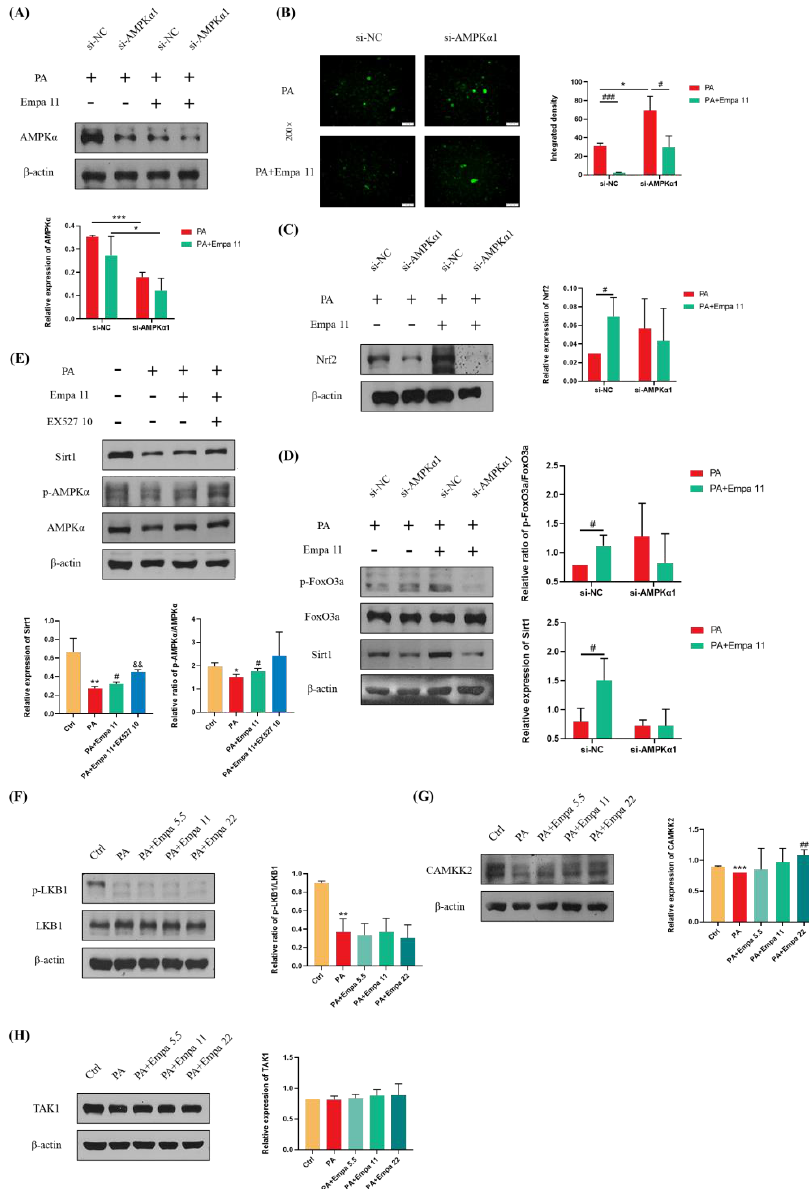
Figure 6. Effects of AMPK α 1 on the protective effects of Empa in a PA-induced lipotoxicity in LO2 cell lines and CAMKK2-mediated activation of AMPK α but not phosphorylation of LKB1 or TAK1. ( A ) AMPK α 1 knockdown treatment significantly reduced the level of AMPK α in LO2 cells. ( B ) AMPK α 1 knockdown treatment enhanced the intracellular ROS generation induced by PA in LO2 cells while inhibiting the ameliorative effect of Empa on the ROS produced by PA. ( C , D ) Empa enhanced the expression of Nrf2, Sirt1, and p -FoxO3a in PA-treated LO2 cells, but AMPK α 1 knockdown treatment partially inhibited this enhancement. ( E , F ) Empa did not regulate AMPK α activation through Sirt1 or the phosphorylation of LKB1 in the PA-induced lipotoxicity model. ( G ) CAMKK2 protein level was remarkably upregulated by Empa treatment. ( H ) Neither PA treatment nor PA + Empa treatment had a significant effect on the expression of TAK1. All data are expressed as mean ± SD ( n = 3). ( A – D ) * p < 0.05 and *** p < 0.001 versus si-NC; # p < 0.05 and ### p < 0.001 versus PA. ( E – H ) * p < 0.05, ** p < 0.01, and *** p < 0.001 versus Ctrl; # p < 0.05 and ## p < 0.01 versus PA; && p < 0.01 versus PA + Empa 11. Ctrl, PA-untreated normal control group; PA, PA-treated control group; PA + Empa 5.5–22, PA-treated and Empa-treated (at final concentrations of 5.5, 11, and 22 µ M)